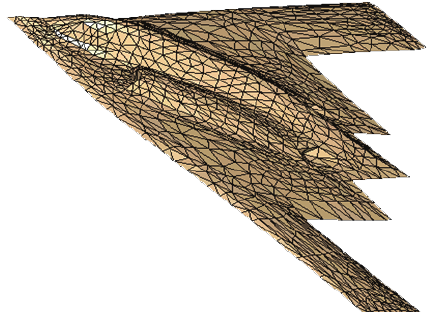
Figure 2: Airplane model using FEMAP ( 𝐿 × 𝑊 × 𝐻 (m): 49.05 × 56.39 ×